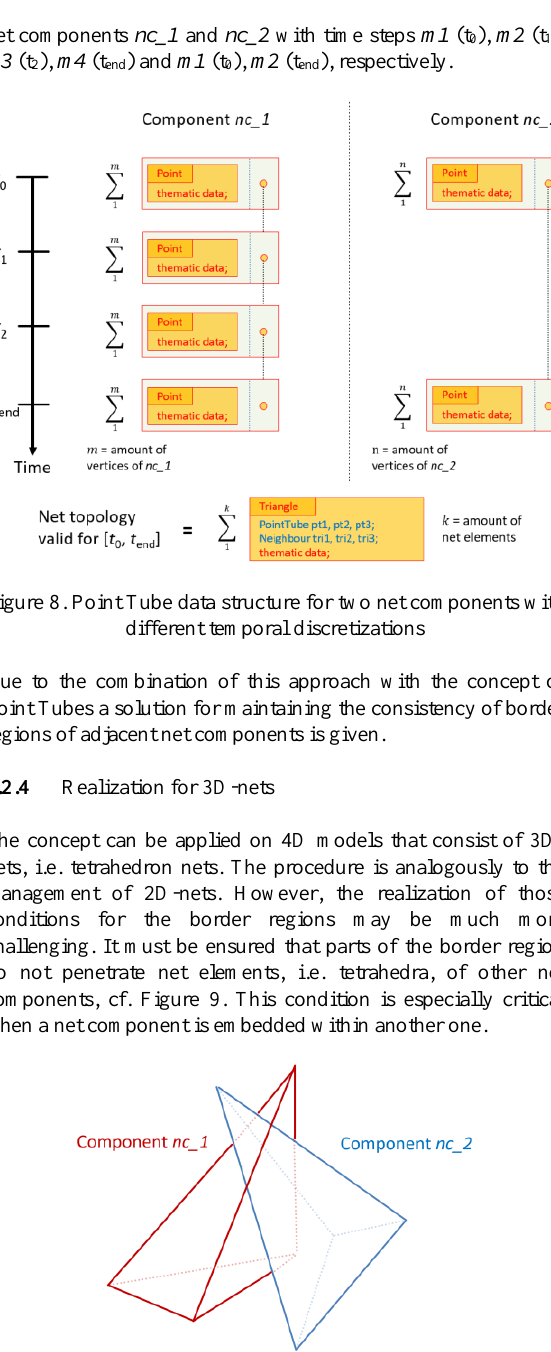
Figure 9. Violation of the net topology consistency due to modifications at the border region between two 3D-net components with different temporal discretisations The management of such border regions is realized with the help of Point Tubes. The net topology of the border region itself must be kept in a consistent state according to the rules of the Point Tube concept. When managing adjacent 3D-net components with different temporal resolutions, this problem should be significantly reduced compared to embedded